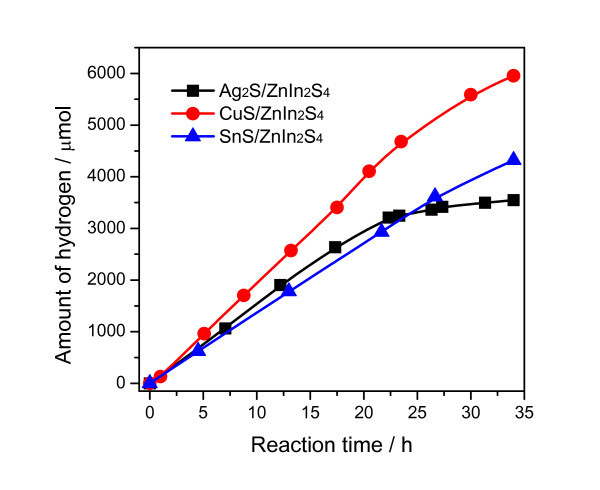
Time courses of H2 evolution. The time courses of H2 evolution over Pt-loaded MS/ZnIn2S4 (MS = Ag2S, SnS, and CuS) under solar light irradiation.